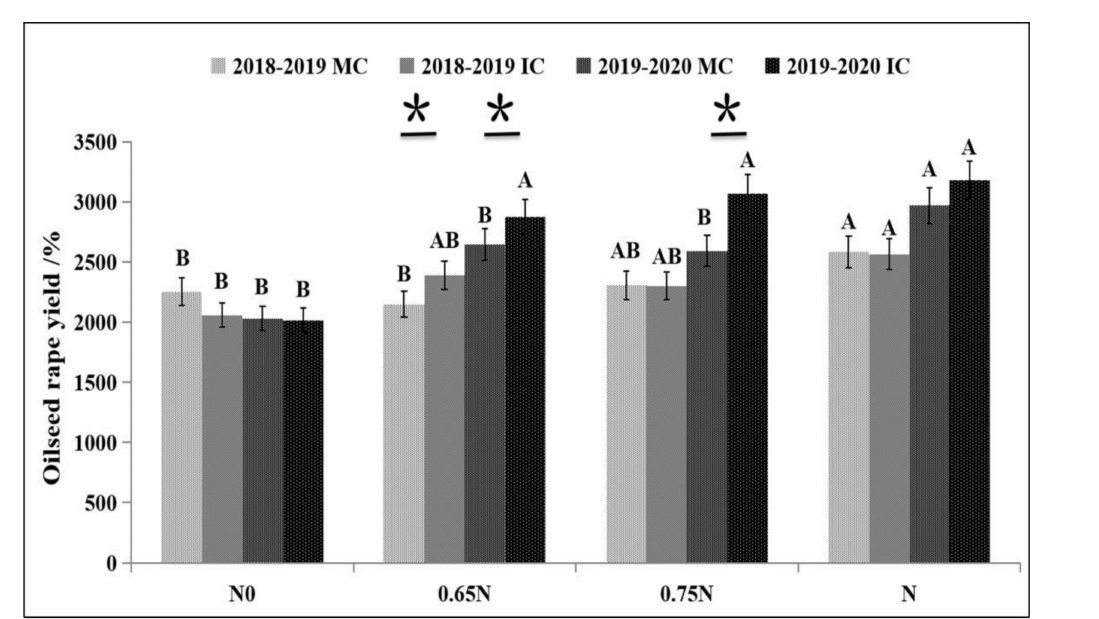
Figure 3. Effects of different treatments on the grain yield of oilseed rape (kg ha − 1 ). Note: * Represents the significant difference between MC and IC at the same nitrogen dose in the same year; capital letters indicate the difference between treatments with different nitrogen doses in the same year and the same